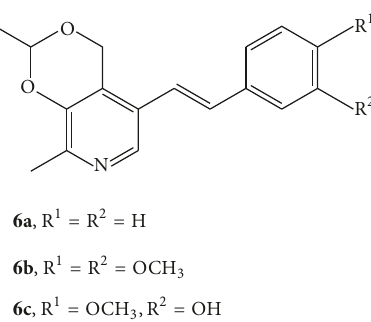
Figure 2: 5-Phenylethenyl substituted pyridoxine derivatives described in our recent work [5] and studied in the cytotoxicity screening